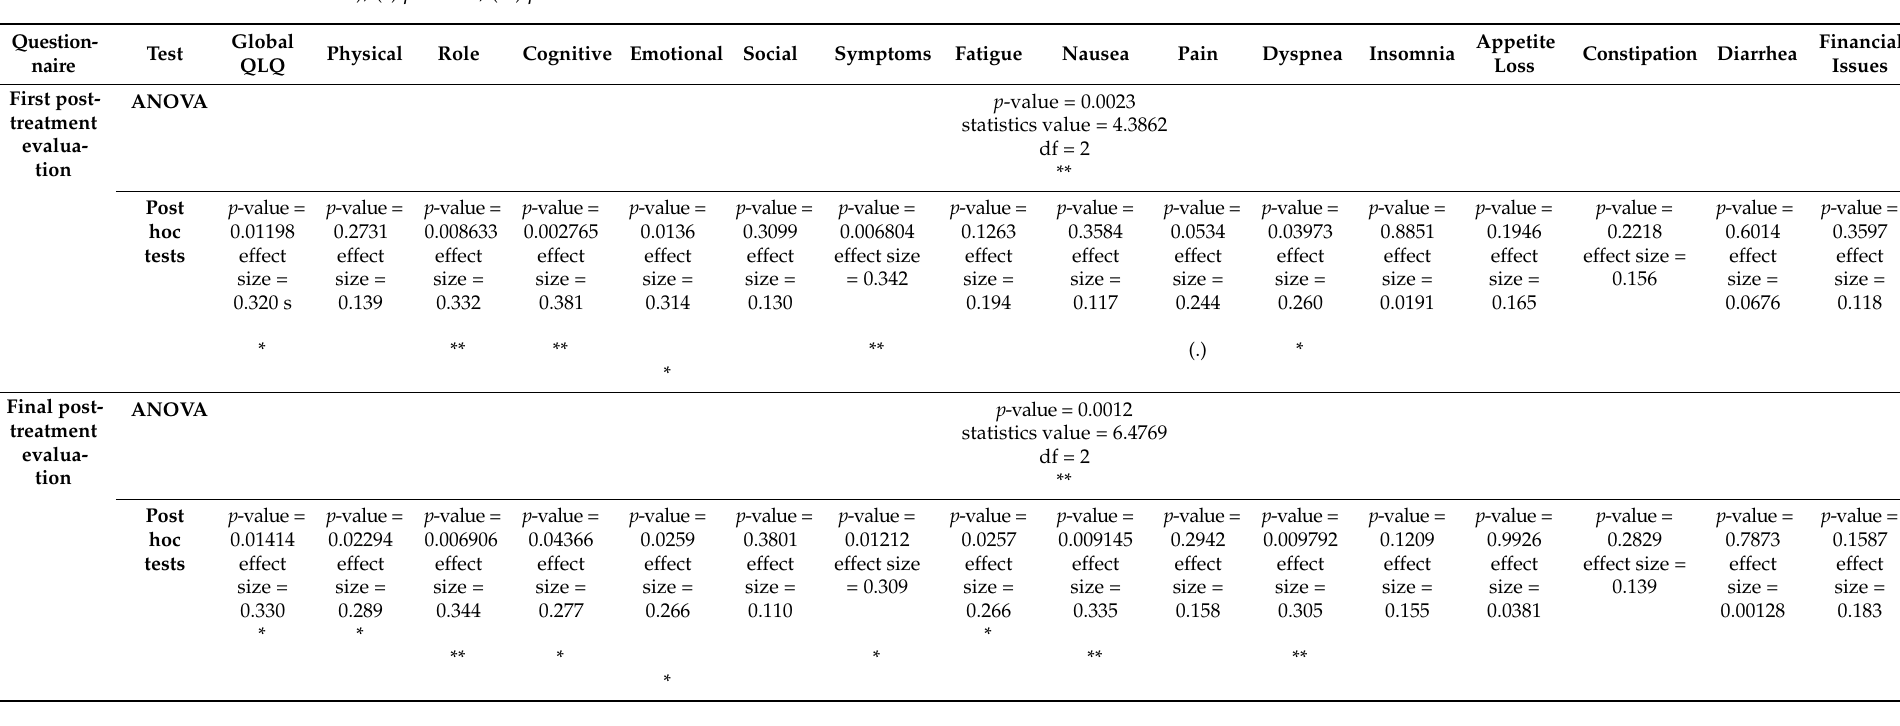
Table A3. Statistical tests performed after baseline correction to compare the hippotherapy and control groups, in order to assess the difference in score evolution for all the QLQ-C30 items, at first post-treatment evaluation and final post-treatment evaluation. First, a robust between–within participants ANOVA was performed to evaluate as to whether the two therapies were following a different behavior, with respect to the QoL items, for each questionnaire (Q2 and Q3). If significant, post hoc tests (two-sided Wilcoxon) were performed for each item to determine statistical differences between the two groups. (.) close to significance (between 0.08 and 0.05); (*) p < 0.05; (**) p <